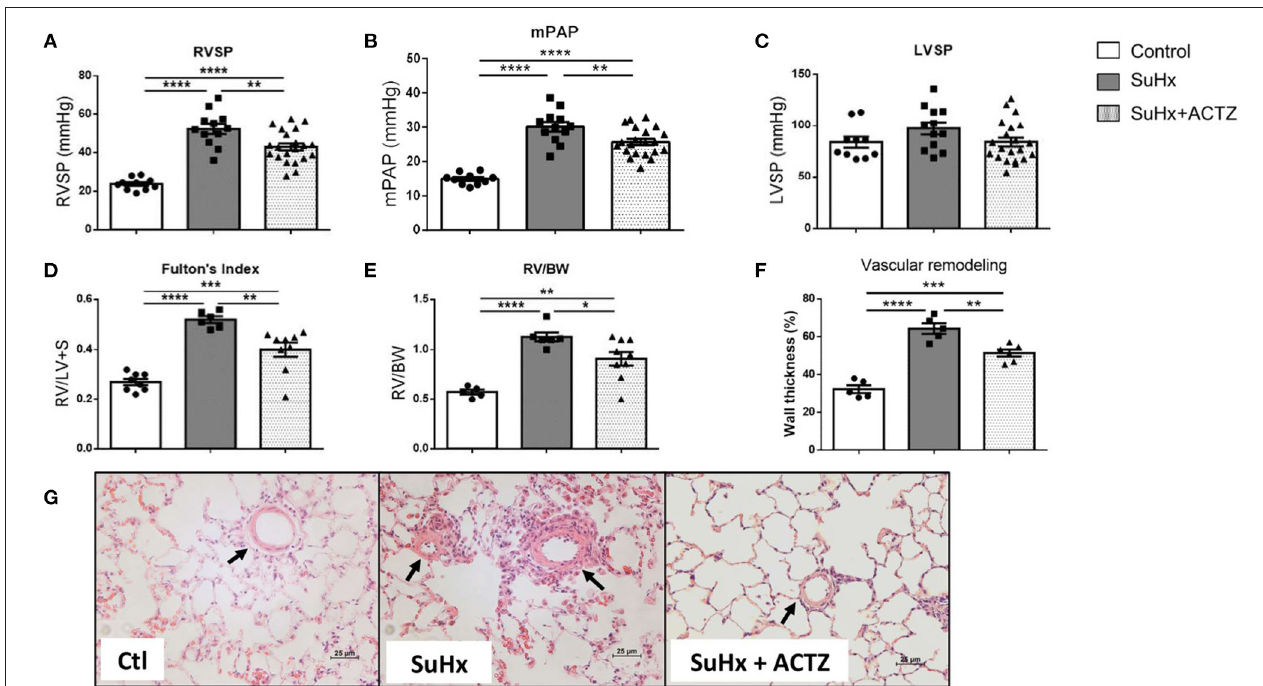
FIGURE 3 | Treatment with acetazolamide (ACTZ) ameliorates Sugen 5416/hypoxia (SuHx)-induced pulmonary hypertension (PH). Improved hemodynamic parameters with ACTZ treatment (A) Right ventricular (RV) systolic pressure (RVSP), (B) mean pulmonary artery pressure (mPAP), and (C) left ventricular systolic pressure (LVSP) in mmHg in the three experimental groups [control (Ctl), SuHx, and SuHx + ACTZ] ( n = 10–21 animals per experimental group). Amelioration of RV hypertrophy (RVH) with ACTZ treatment, (D) Fulton’s index (FI), and (E) RV-to-body weight ratio ( n = 6–9 animals per experimental group) (FI, ratio of RV weight to